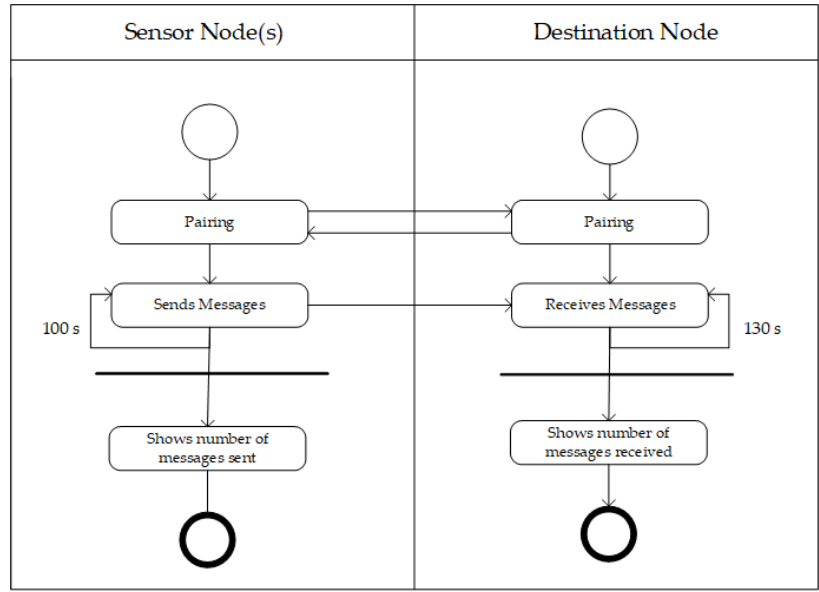
Figure 5. UML modelling of message exchange.